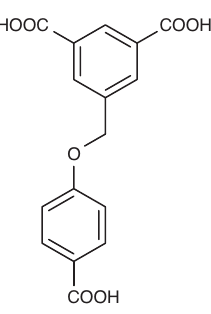
L ligand used in this 3